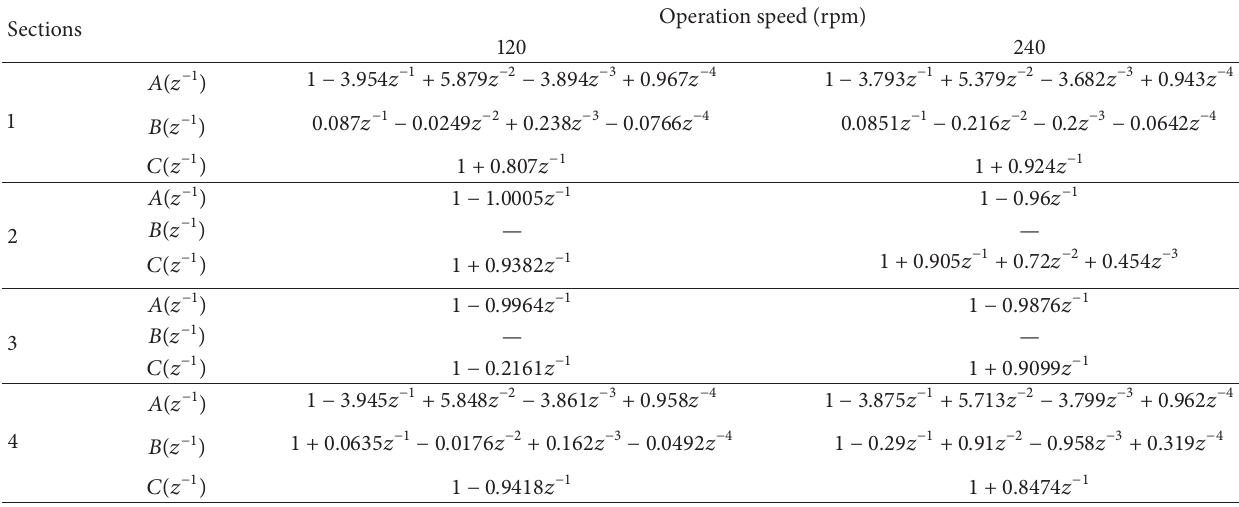
Table 2: Results of system identification for the subsystem